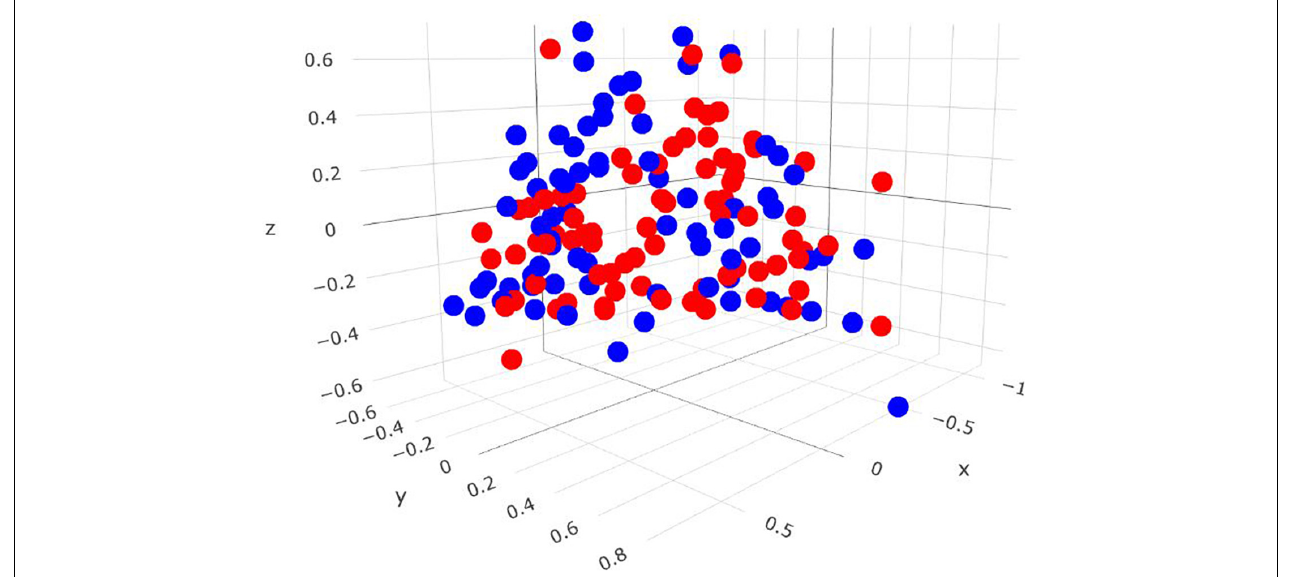
FIGURE 4 | Three-dimensional Bray-Curtis NMDS plot highlighting differences in the archaeal community composition between animals ranked as high and low for residual methane emissions. Red = low RME; blue = high RME. propionate (Evans and Martin, 1997; Denman et al., 2015).